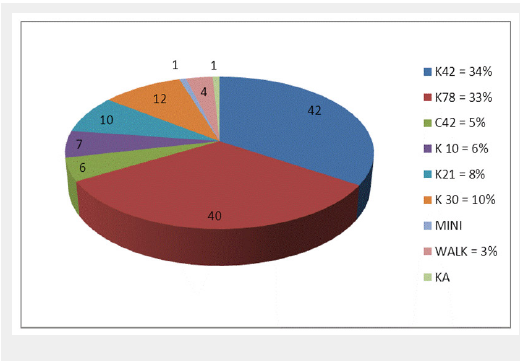
Distribution of the different categories within the group of athletes that completed the questionnaire.